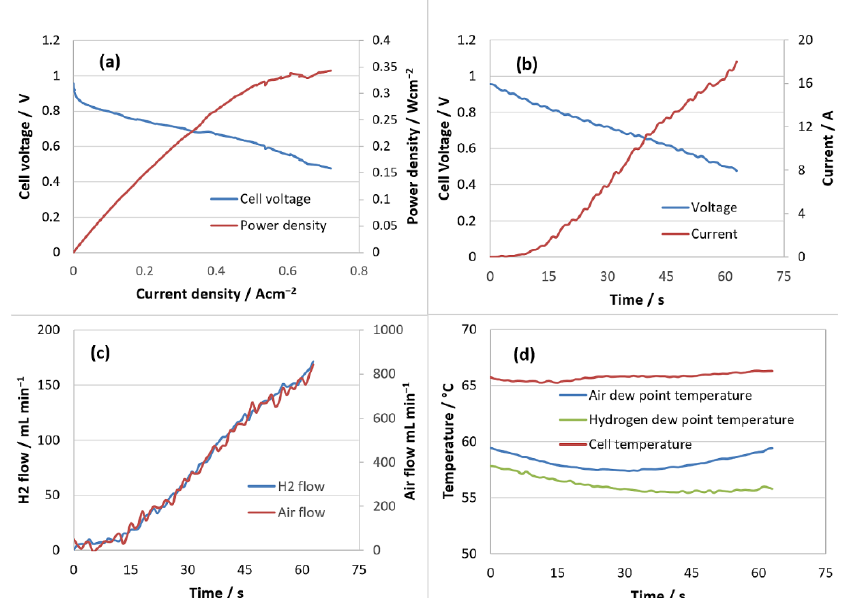
Figure 15. PEMFC performance using N/GO_A -based MEA. ( a ) Polarization and power density curves; ( b ) current variation profile depending on voltage; ( c ) flow rates consumed; ( d ) profiles: temperature of the PEMFC with MEA based on nitrogen doped graphene, and dew points of the reactants.